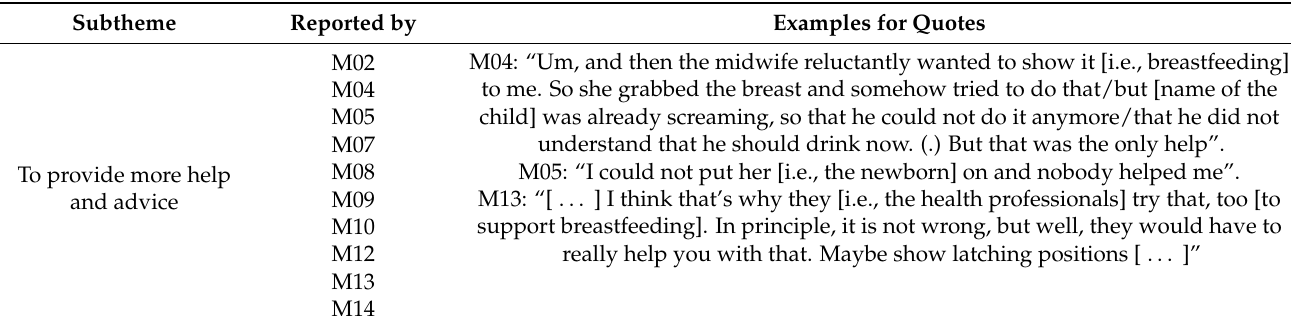
Table 3. Desired Future Breastfeeding Support from Health